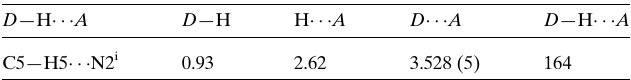
Table 1 Hydrogen-bond geometry (A˚ , (cid:2)